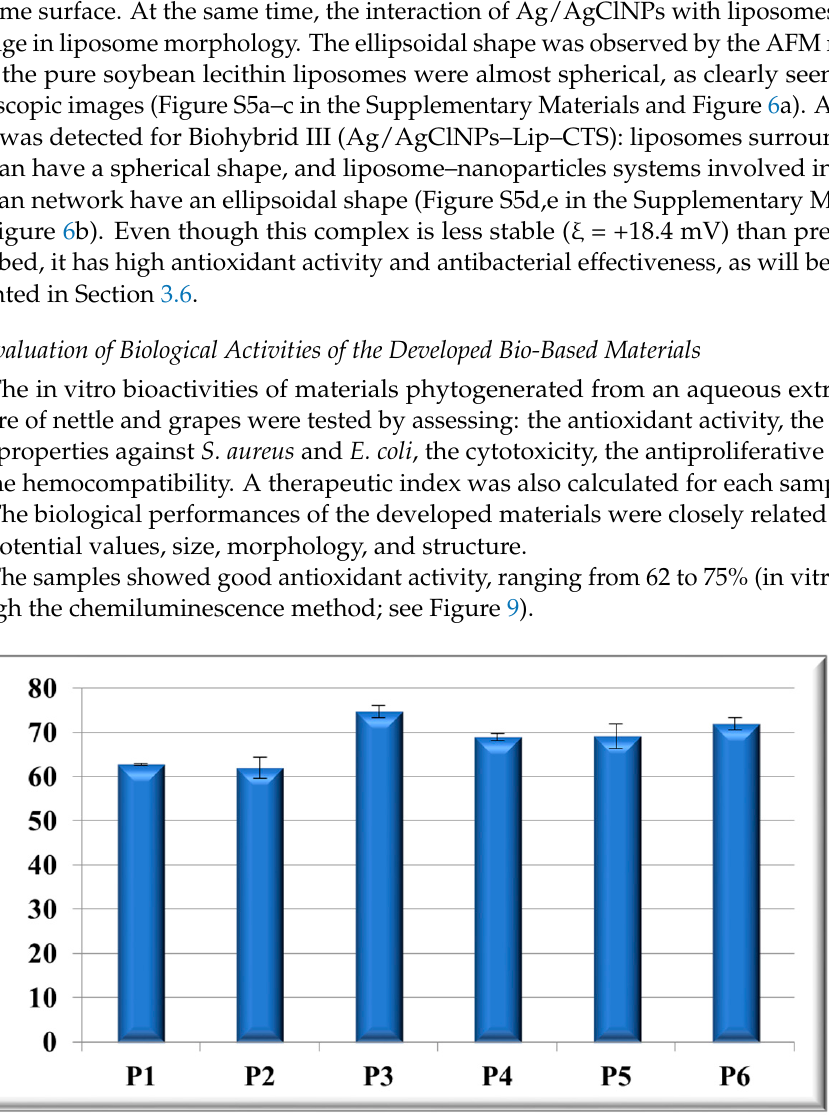
Figure 9. The in vitro antioxidant activity of the developed plasmonic composites and their “building blocks”, evaluated by the chemiluminescence method.